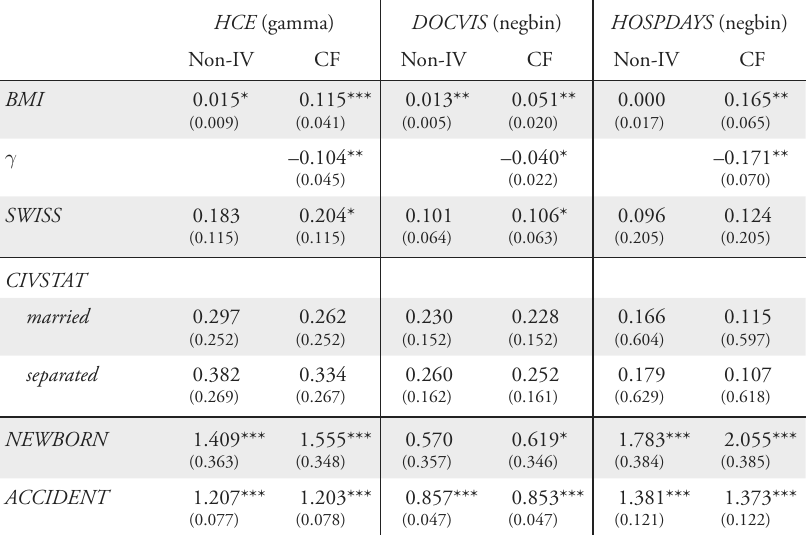
Table 2: Main Results from the GLM